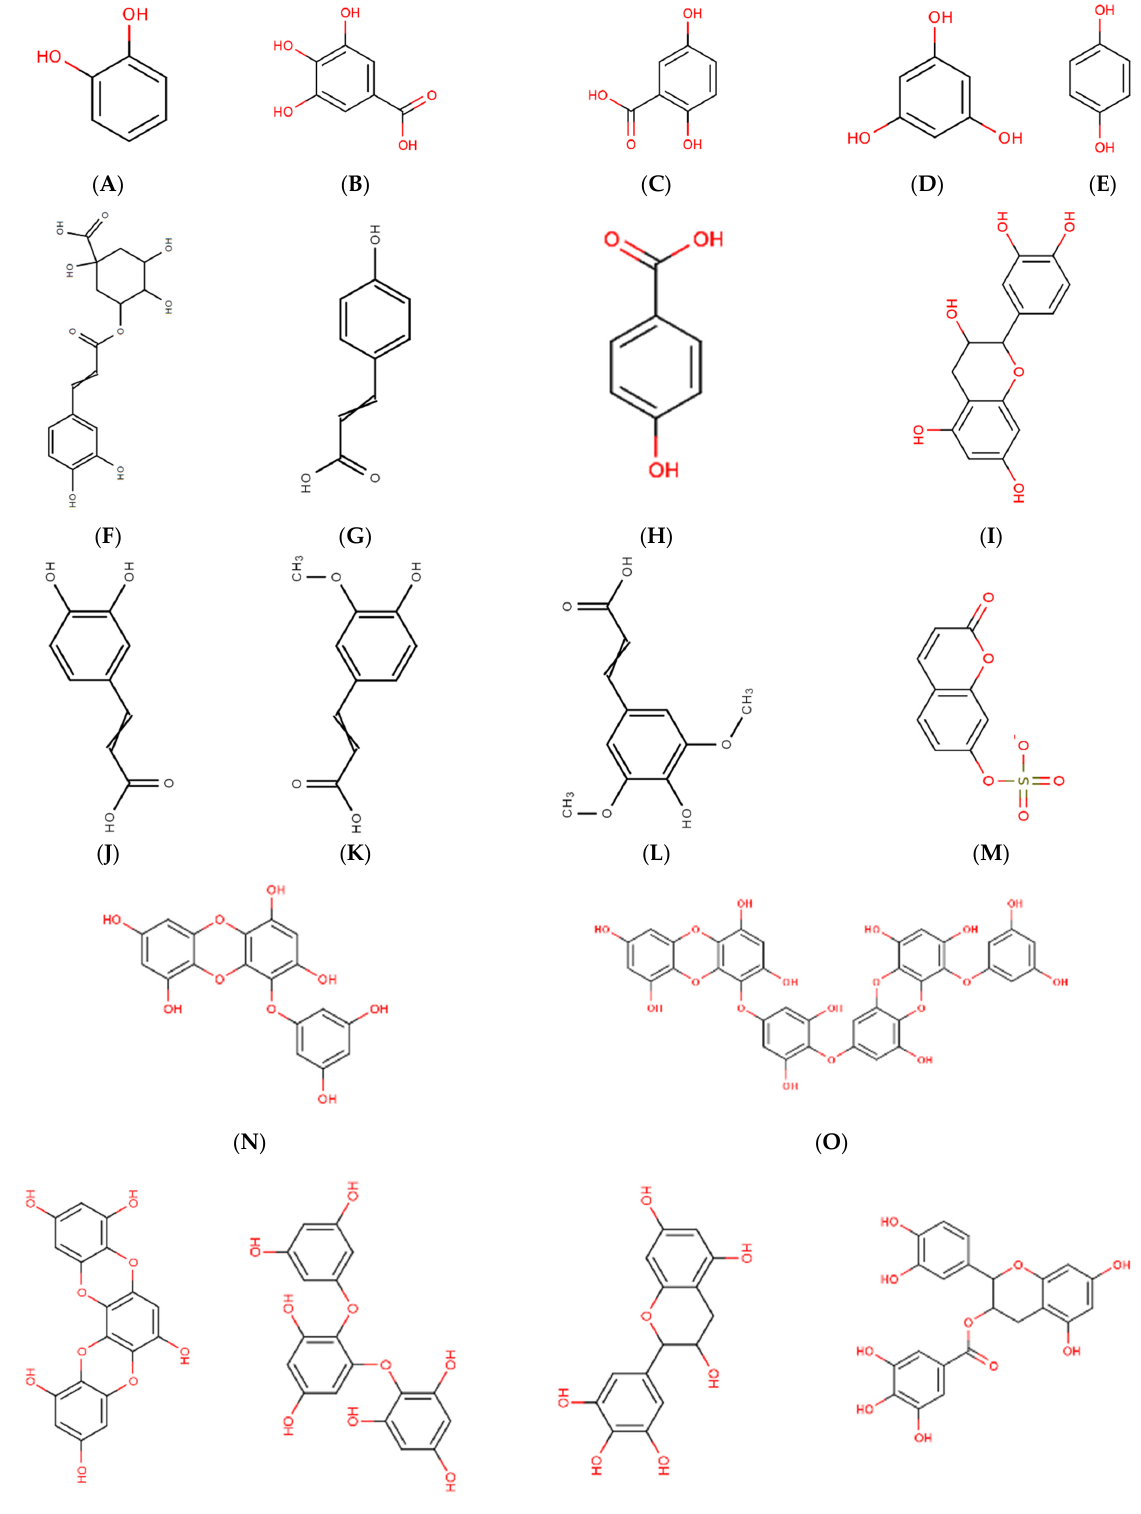
Figure 4. Chemical structures of some phenolic compounds. ( A ): Catechol, ( B ): Gallic acid, ( C ):